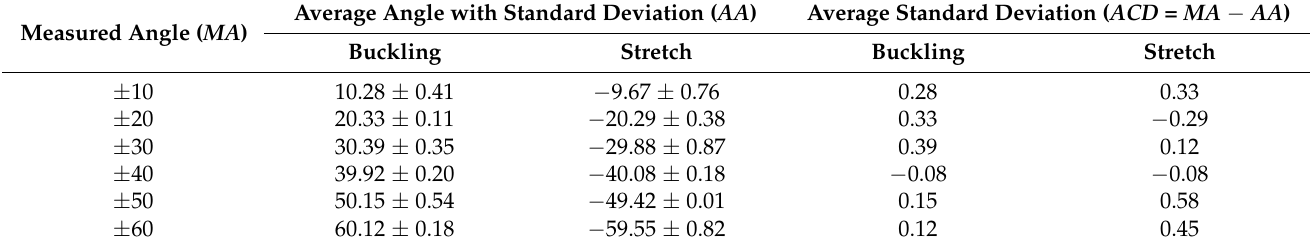
Table 2. Dynamic standard deviation and mean error in the ROMSS with the simulated